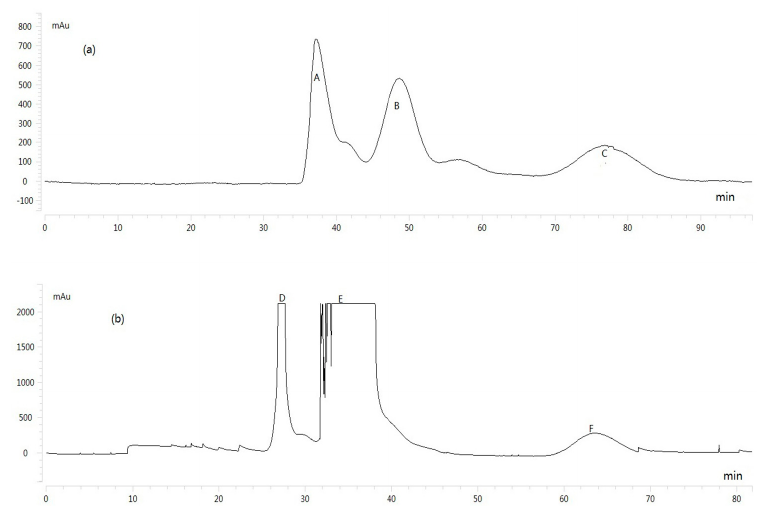
Figure 1. High-speed countercurrent chromatography (HSCCC) chromatogram of the ethyl acetate extract of Veronica ciliata Fisch. ( a ) First separation. Solvent system: n -hexane/ n